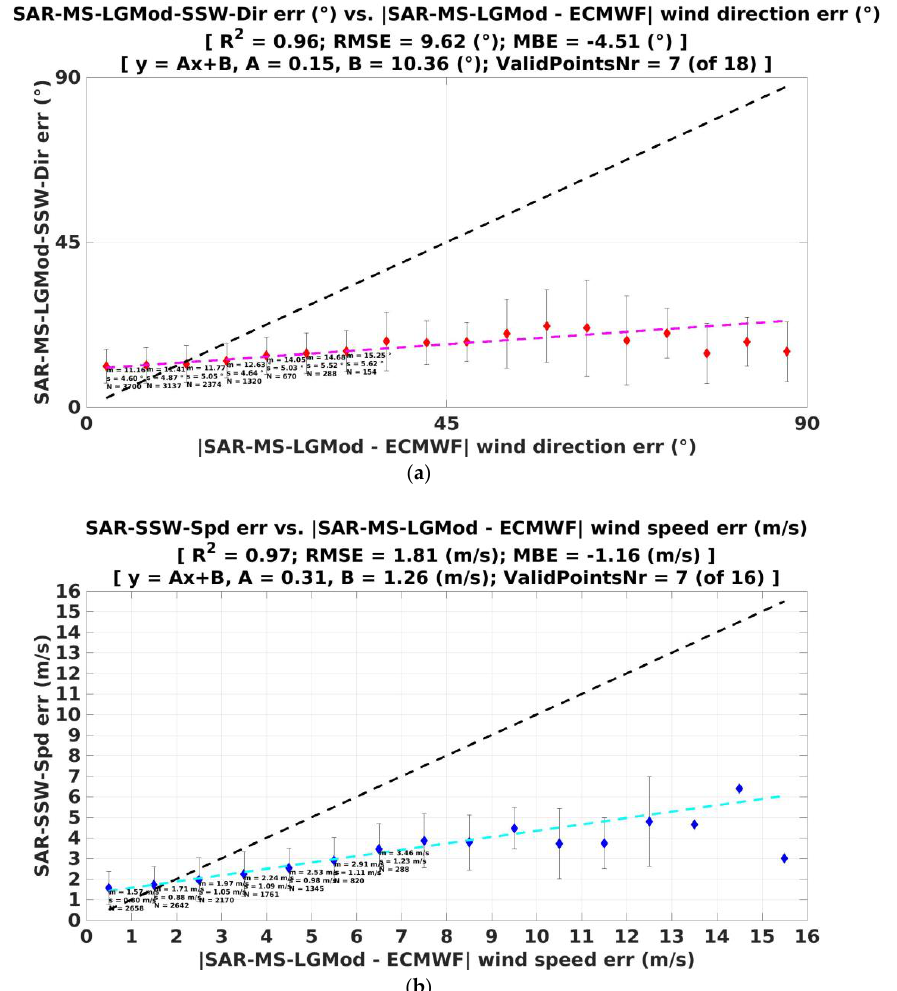
Figure 9. ( a ) 5 ◦ -binned scatterplot of the MS LG-Mod SSW direction uncertainty, ∆ ϕ ( ◦ ), ( y axis) vs. the absolute difference between the MS LG-Mod SSW direction and the ECMWF wind direction ( x axis), for all the 5 km by 5 km ROIs (N_ROI = 11,902). Red dashed line shows the regression line with a slope A = 0.15. ( b ) 1 m/s-binned scatterplot of the SAR SSW speed uncertainty, ∆ W max (m/s), ( y axis) vs. the absolute difference between the SAR SSW speed and the ECMWF wind speed ( x axis), for the same ROIs and for the applied GMF CMOD5.N. Cyan dashed line shows the regression line with a slope A = 0.31. Both black dashed lines represent the reference line with a slope of 1. Note: For each bin, the number of samples in the bin (N) and the aggregate statistics, m (mean) and s (standard deviation), are provided (unless N is too small, i.e., less than 1/100 of